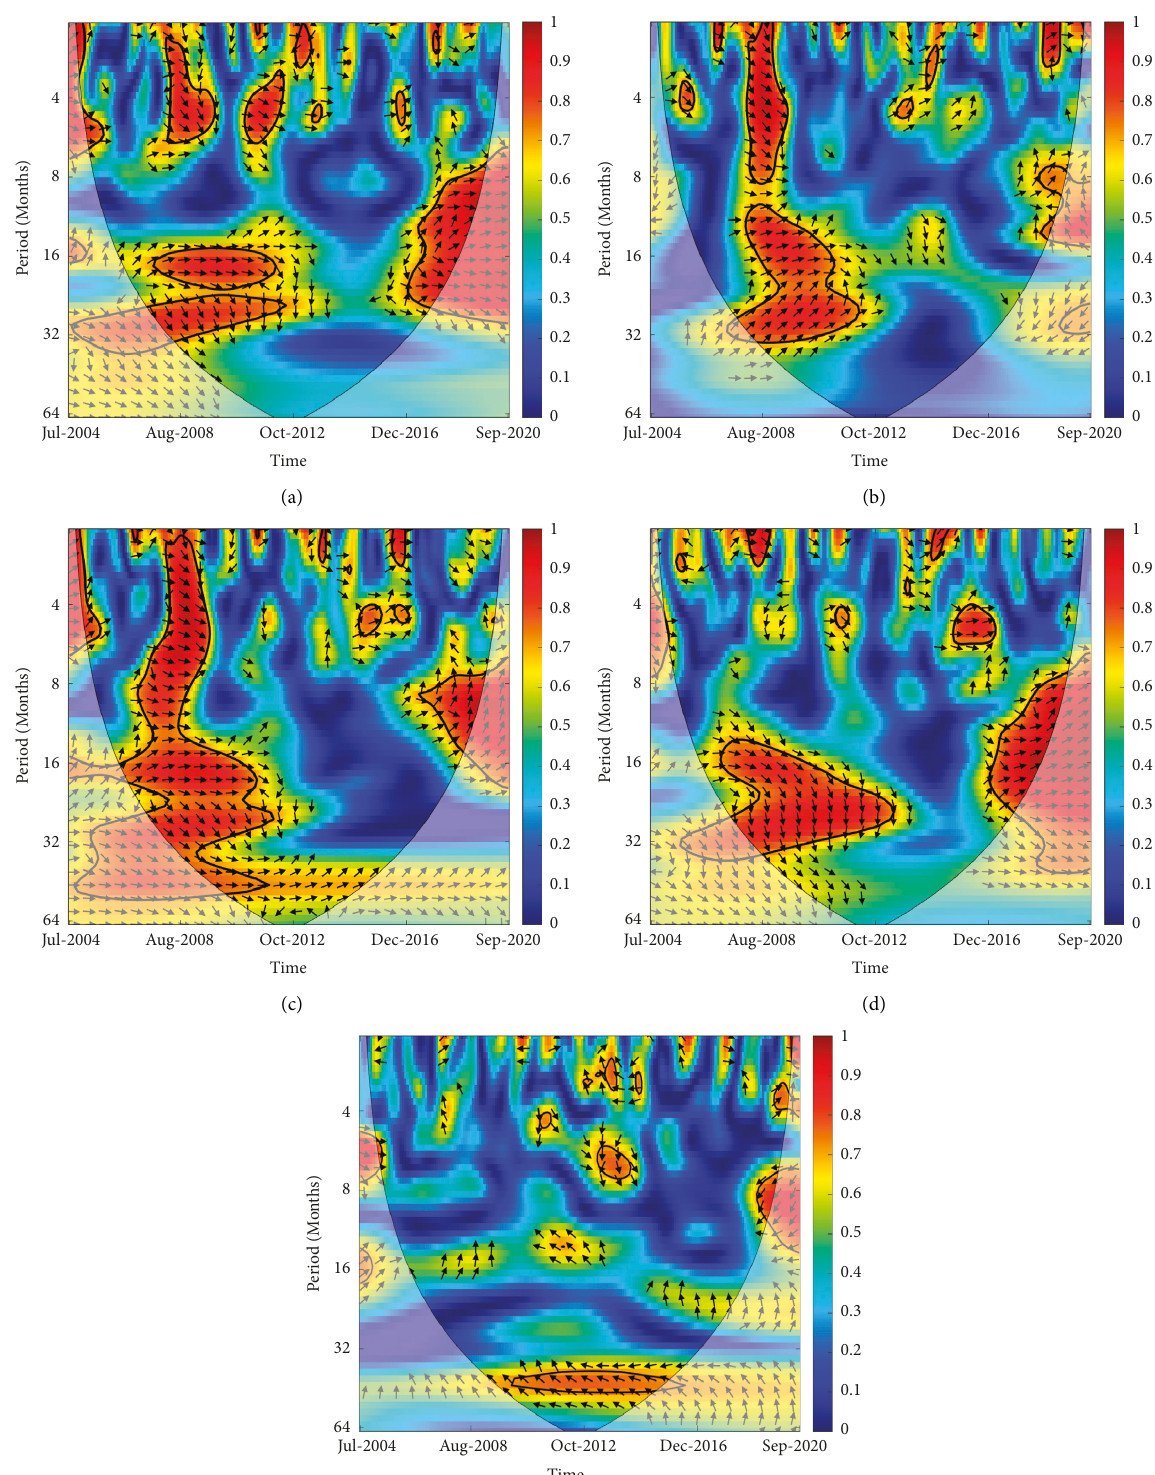
Figure 6: The wavelet coherence and phase plots between the +EPU index and MATV for five sectors (industrials, information technology, materials, real estate, and utilities). (a) EPU and industrials. (b) EPU and information technology. (c) EPU and materials. (d) EPU and real estate. (e) EPU and